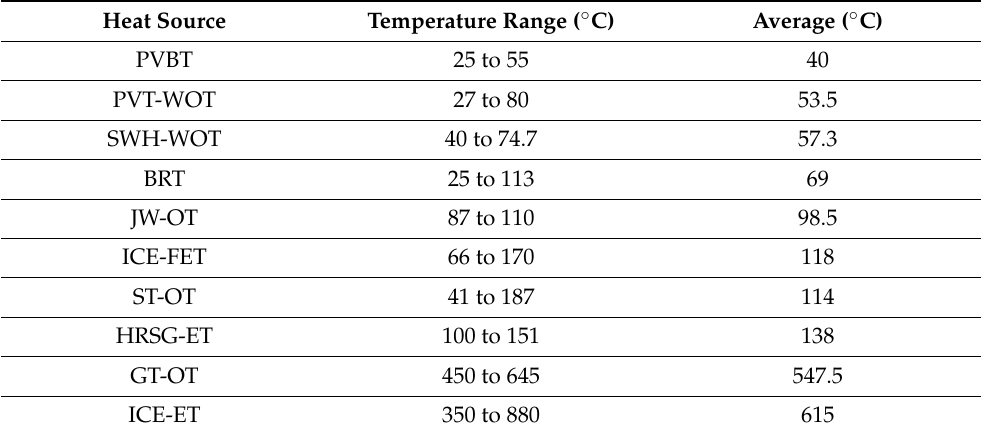
Table 12. Summary of the values for all reviewed parameters.